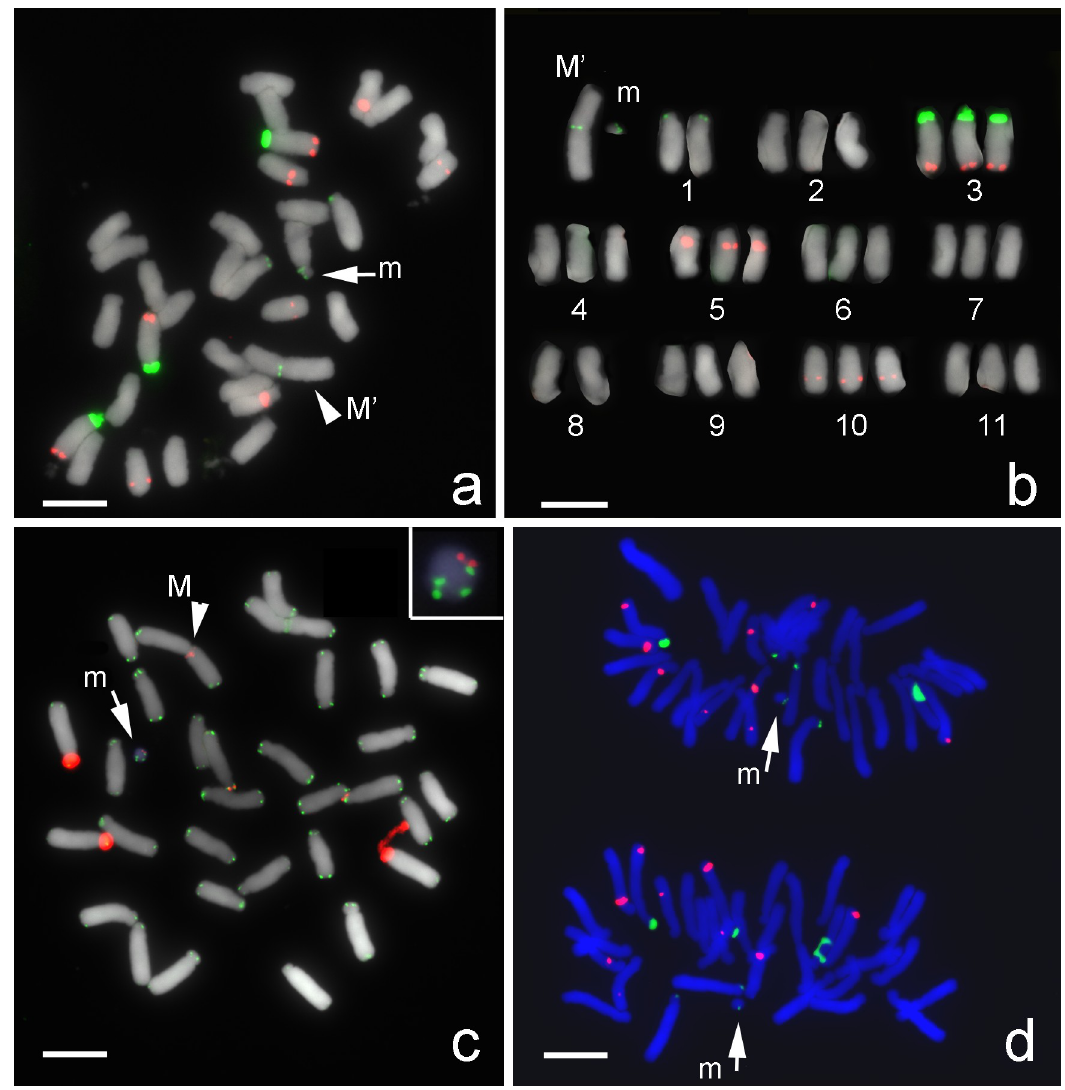
Fig 1. Centromeric fusion detected by FISH with 45S rDNA probe in a triploid variant with karyotype 2n = 33, 31A+1M’+m. (Scale bar = 10 μ m). (a) FISH with 45S rDNA (green) and 5S rDNA (red) as probes. FISH signals of 45S rDNA (green) were detected at the centromeric region of a large M-type chromosome (M’; arrowhead) and at a small M-type chromosome (m; arrow). (b) Individual chromosomes from Fig 1A were arranged according to their FISH signal patterns, morphology, and lengths in descending order. The M’ chromosome was possibly formed by a fusion between chromosome 1 and chromosome 8. (c) FISH with 45S rDNA and telomeric DNA as probes. Both 45S rDNA (red) and telomeric sequence (green) were detected at m chromosome (arrow) and M’ chromosome (arrowhead). Inset shows an enlarged image of the m chromosome with two 45S rDNA signals (red) and four telomere signals (green). (d) FISH with 5S rDNA (red) and 45S rDNA (green) as probes on chromosomes at anaphase. Two m-type chromosome (arrows) were even separated into two daughter